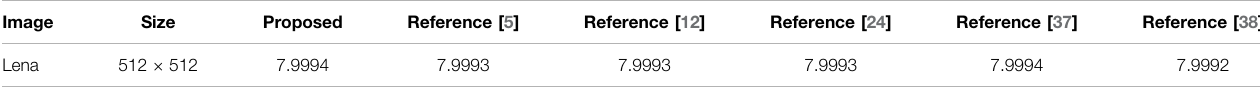
TABLE 8 | Comparison results of IE values with different scheme. Image